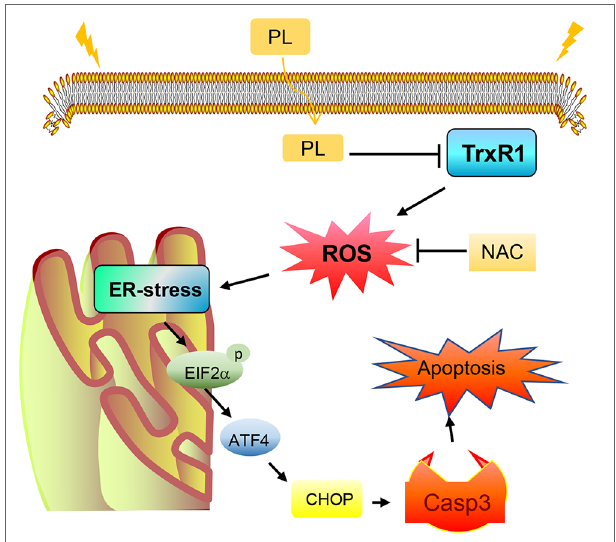
FIGURE 7 | Schematic illustration of the underlying mechanism of the anticancer activity of